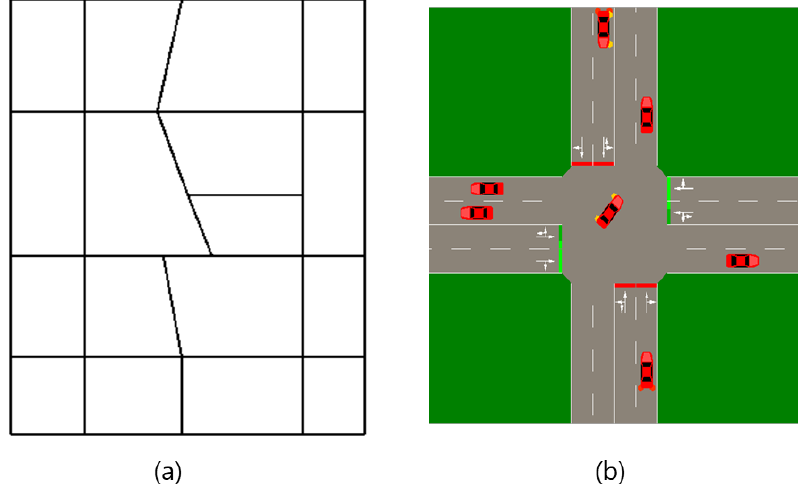
Figure 6. Simulation city roadways ( a ) and intersection structure ( b